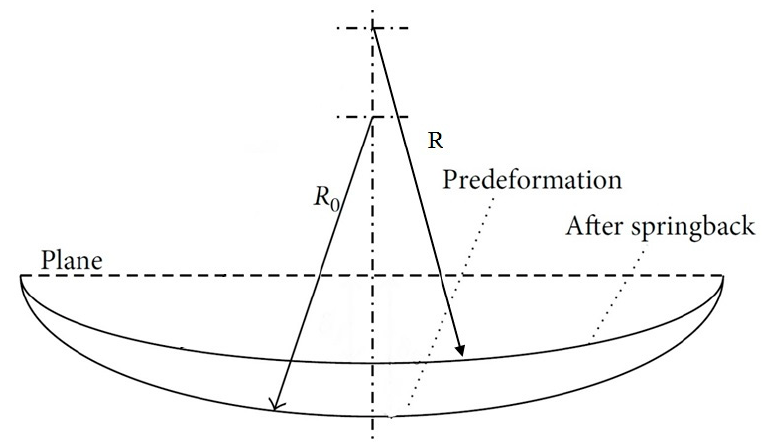
Figure 4. Schematic view of a creep age formed FML before and after the springback phenomenon. (Adapted from [27], with permission from Springer Nature, 2021.)